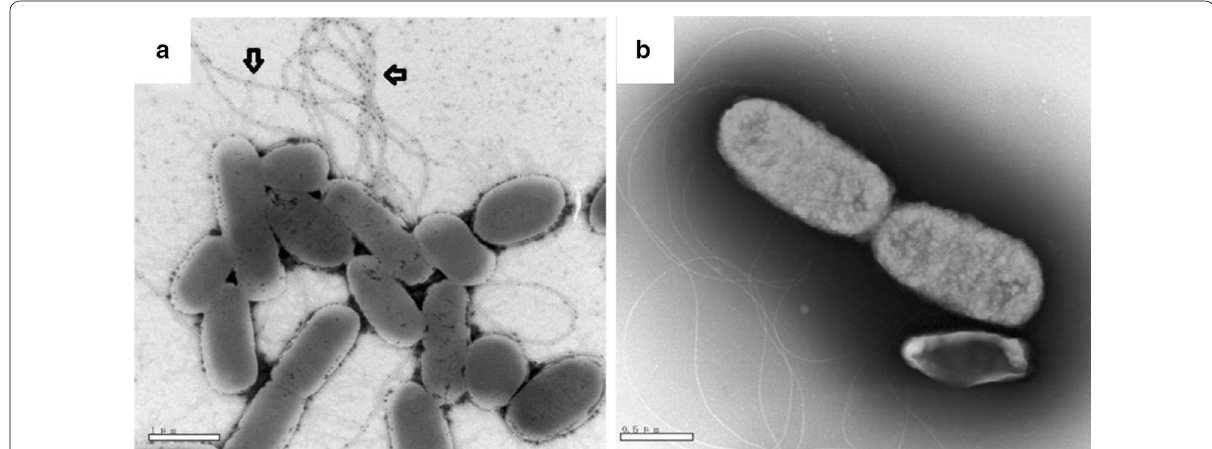
Fig. 3 Immunogold electron microscopy analysis of the binding of MAb 3E2 and SE50336 filament. a Bacteria cells were incubated with 3E2 MAb followed by reaction with colloidal gold-labelled goat anti-mouse IgG as described in “Materials and methods”. Colloidal gold particles (as the arrow showed) were visualized on the surface of filament demonstrate that 3E2 MAbs were able to recognize and bind to the filament of SE50336. b Negative control sample was incubated with same amount of PBS instead of 3E2 MAb